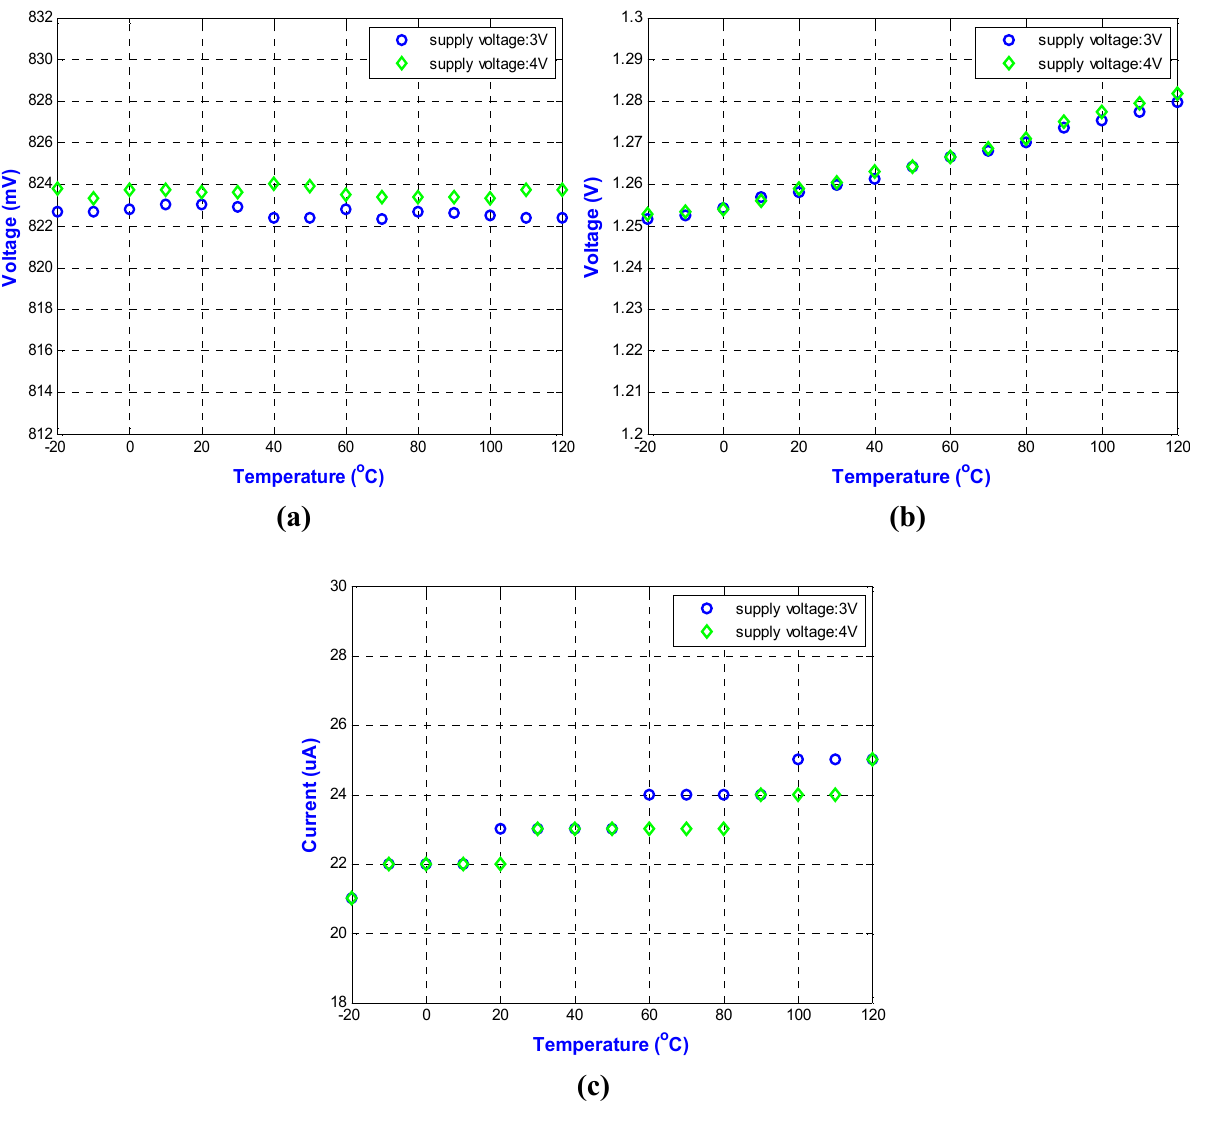
Figure 15. Measurement results for (a) voltage references, V , and (c) current reference, I V REF ,5 V